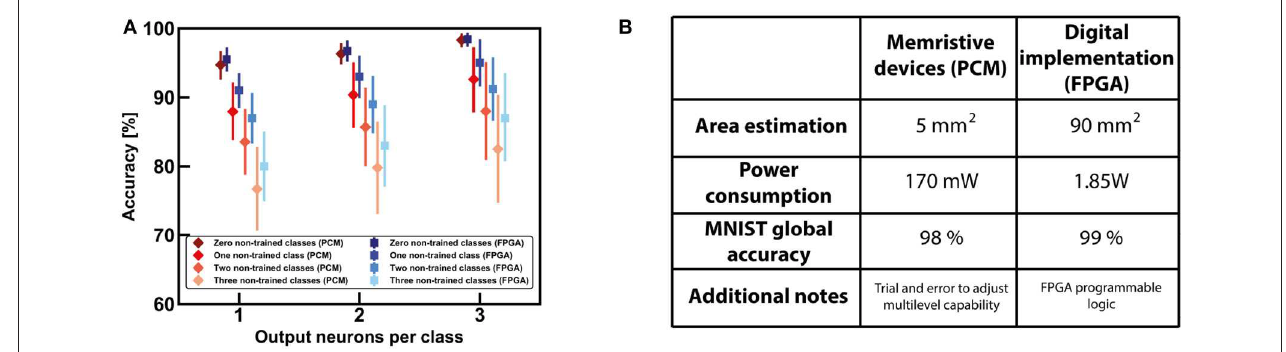
FIGURE 13 | (A) Global accuracies for 0, 1, 2, 3 non-trained classes of MNIST dataset for both an FPGA-based design and a PCM-based approach. (B) Table of comparison for the two approaches in terms of area estimation, power consumption and global accuracy after training all the dataset.